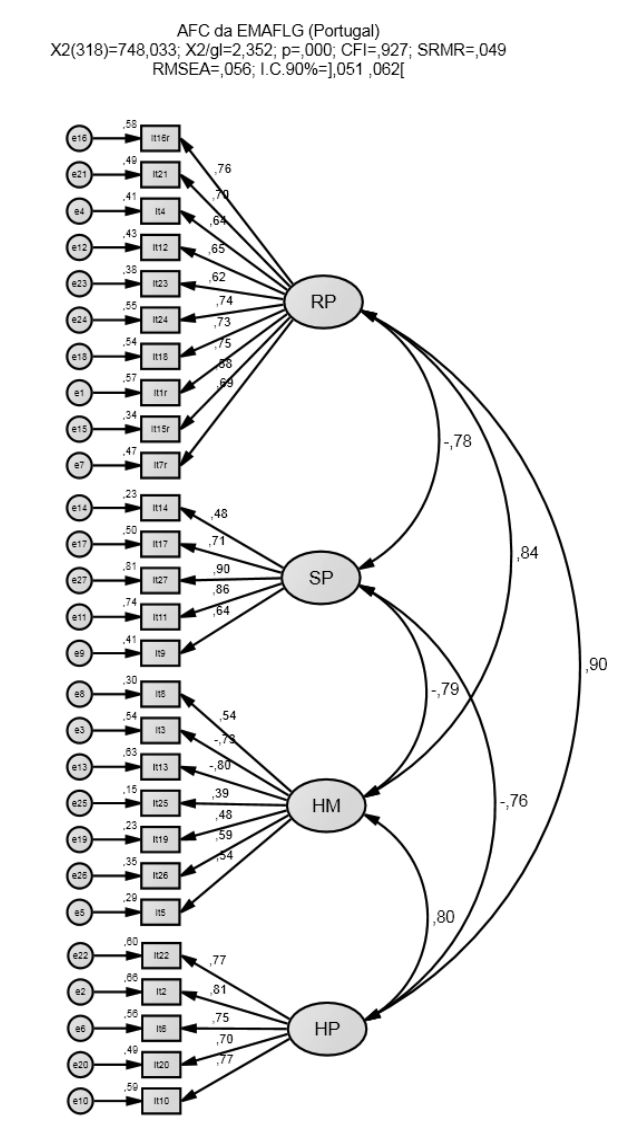
Figura 1 . Análise fatorial con fi rmatória da EMAFLG na amostra portuguesa ( N =